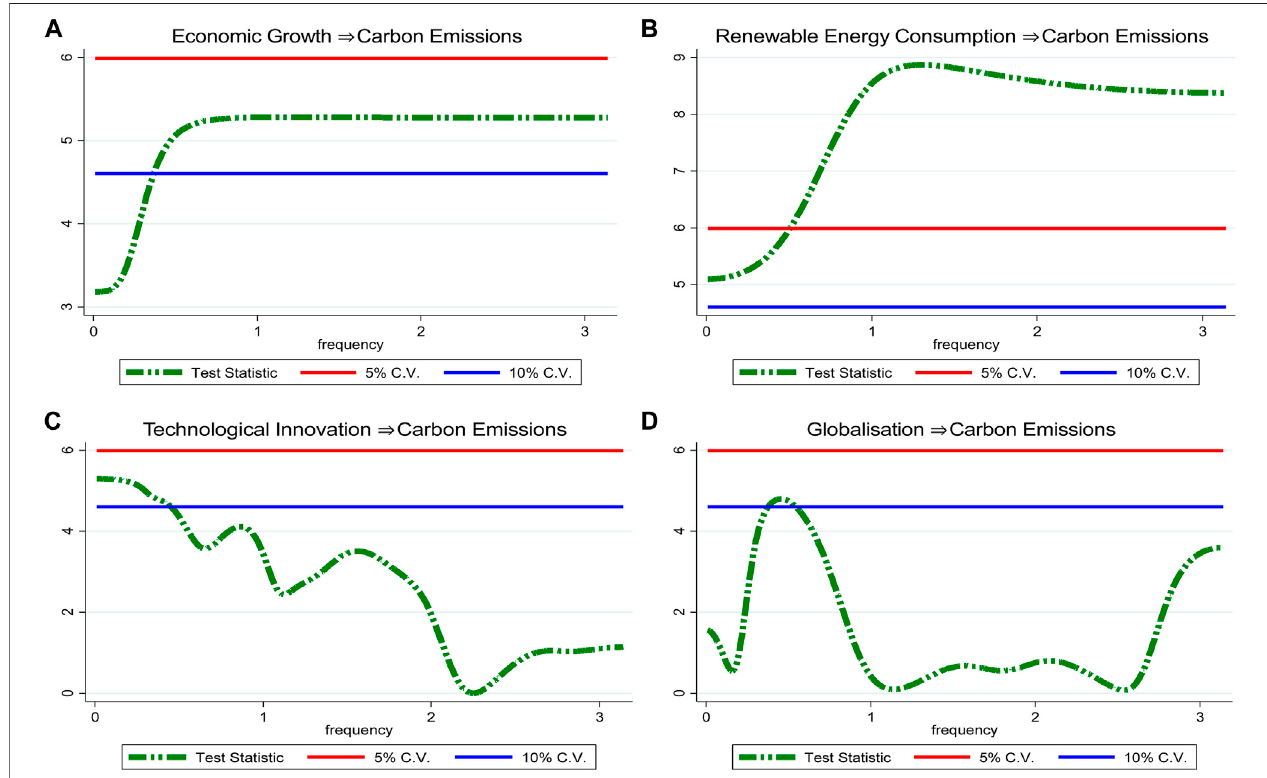
FIGURE9| (A)SpectralcausalityfromGDPtoCO 2 . (B) SpectralcausalityfromRENtoCO 2 . (C) SpectralcausalityfromTItoCO 2 . (D) SpectralcausalityfromGLOtoCO 2 .